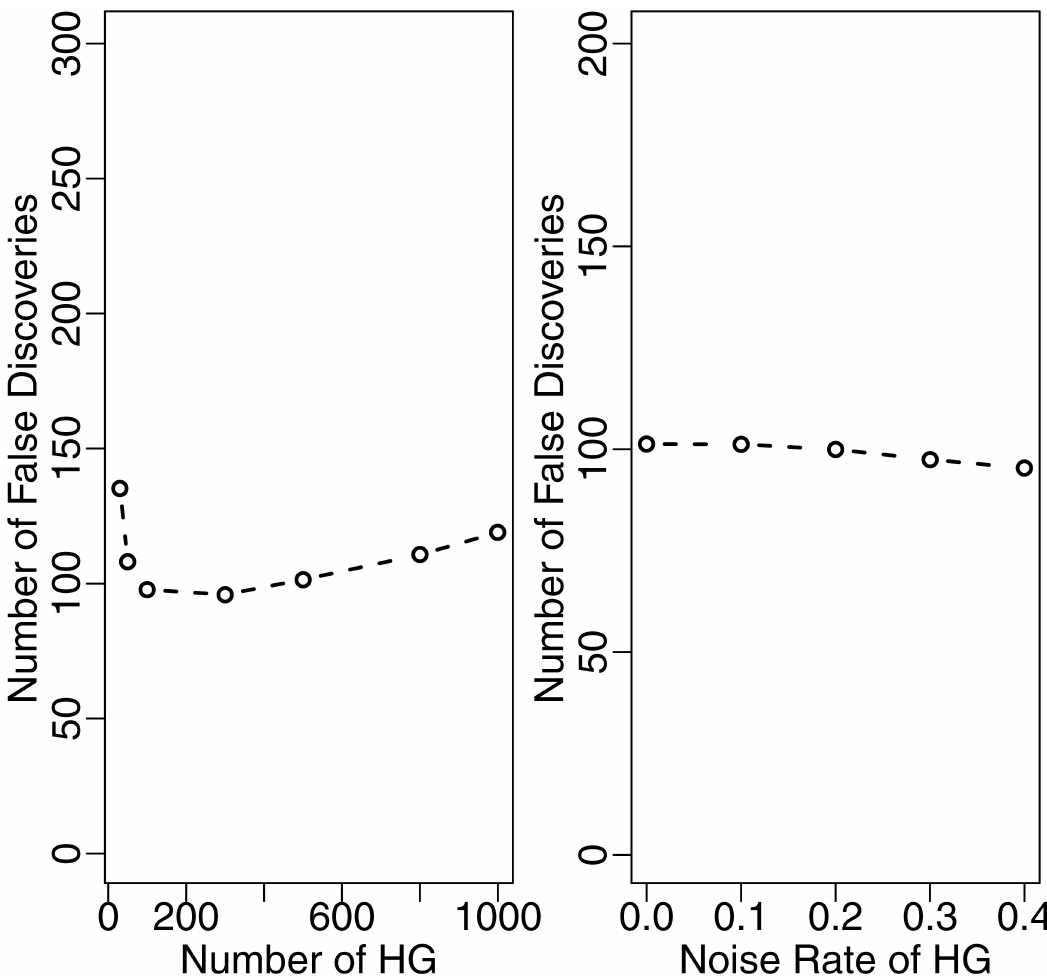
Fig 4. False discovery number for different numbers of housekeeping genes and different rates of noise in housekeeping genes with HTN